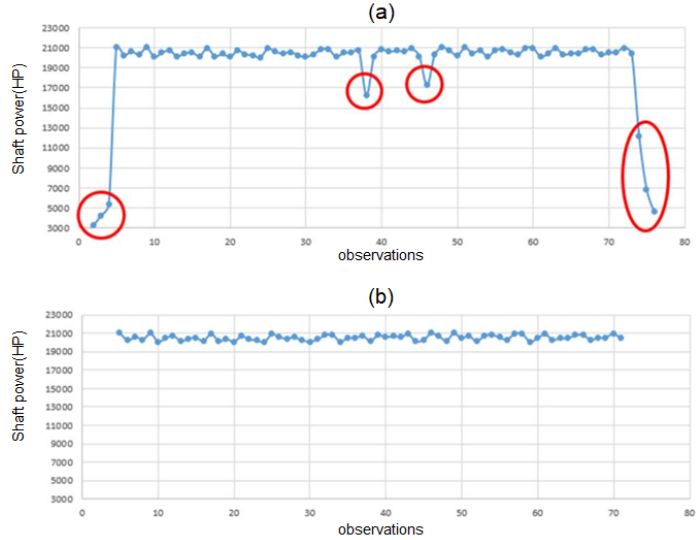
Figure 3. An example of outlier detection using Chauvenent’s criterion; 75 observations were randomly chosen from the dataset. ( a ) Before outlier detection. ( b ) After outlier detection.